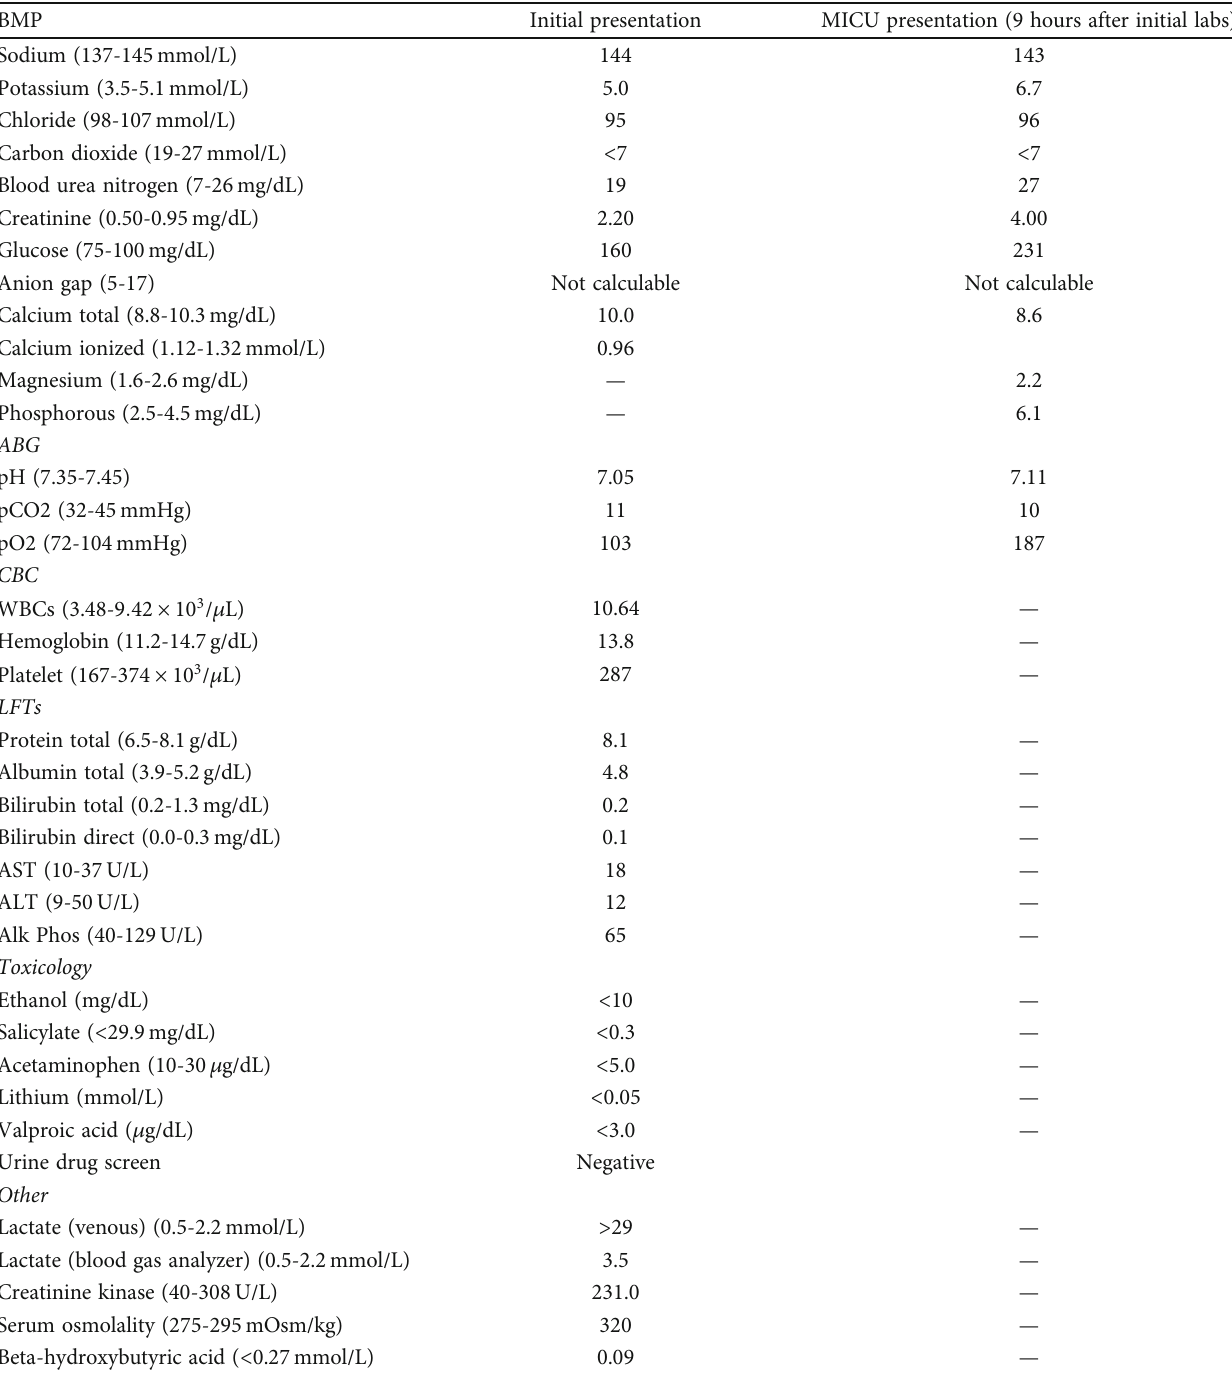
Table 1: Serum lab